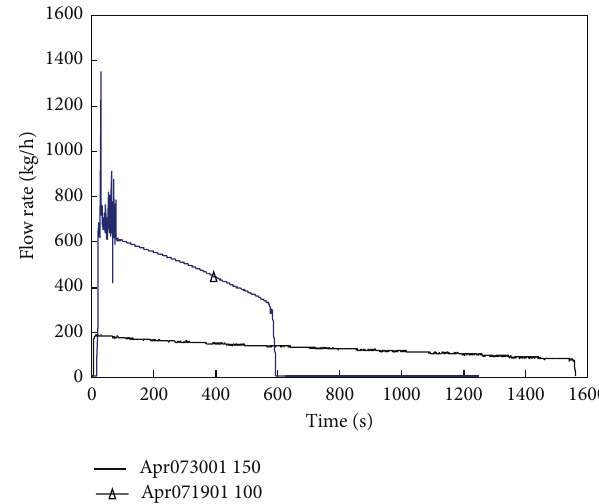
Figure 8: Water hammer influenced by resistance of feedwater